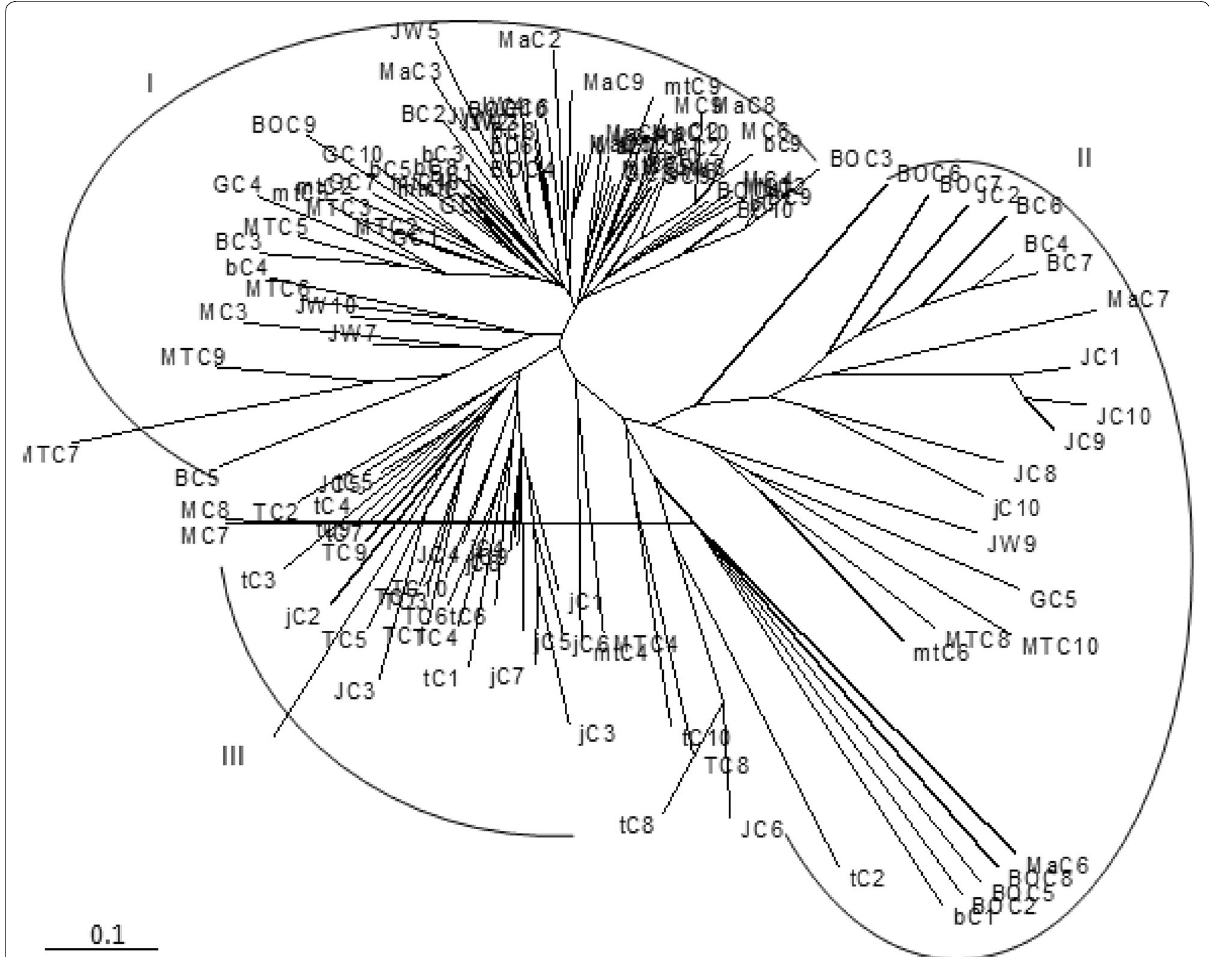
Fig. 3 Neighbor-joining clustering of 129 individuals of Aframomum corrorima based on ISSR data generated from seven primers. The algorithm is based on Jaccard’s coefficients of similarity obtained after pair-wise comparison of the presence-absence